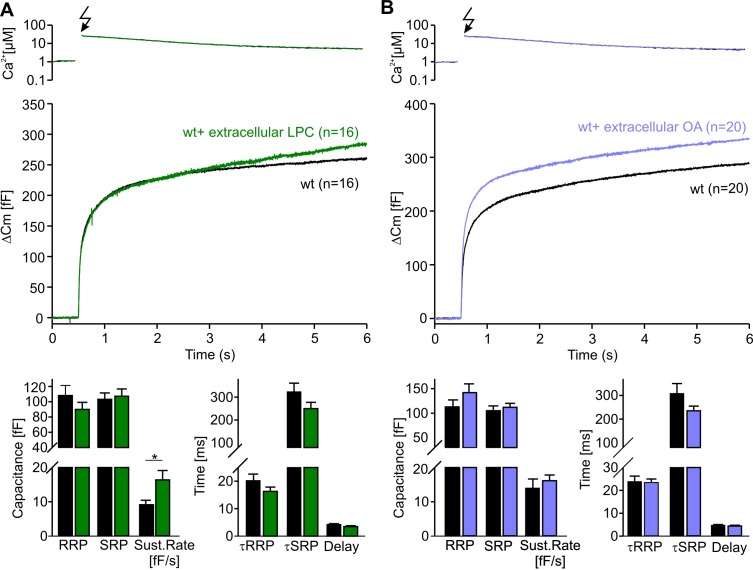
Extracellular application of LPC or OA does not affect overall secretion.(A,C) Mean flash-induced [Ca2+]i levels (top panel) and corresponding CM responses (lower panels) of wt cells with extracellular LPC or OA application. (B,D) Neither LPC nor OA affects the extent of secretion (RRP, SRP, sustained rate of release, left panels) or the stimulus-secretion coupling (τRRP, τSRP and the secretory delay, right panels). Arrow indicates UV-flash. Data are represented as mean ± SEM and numbers of cells are indicated within brackets. *, p<0.05, Mann-Whitney Rank sum test.